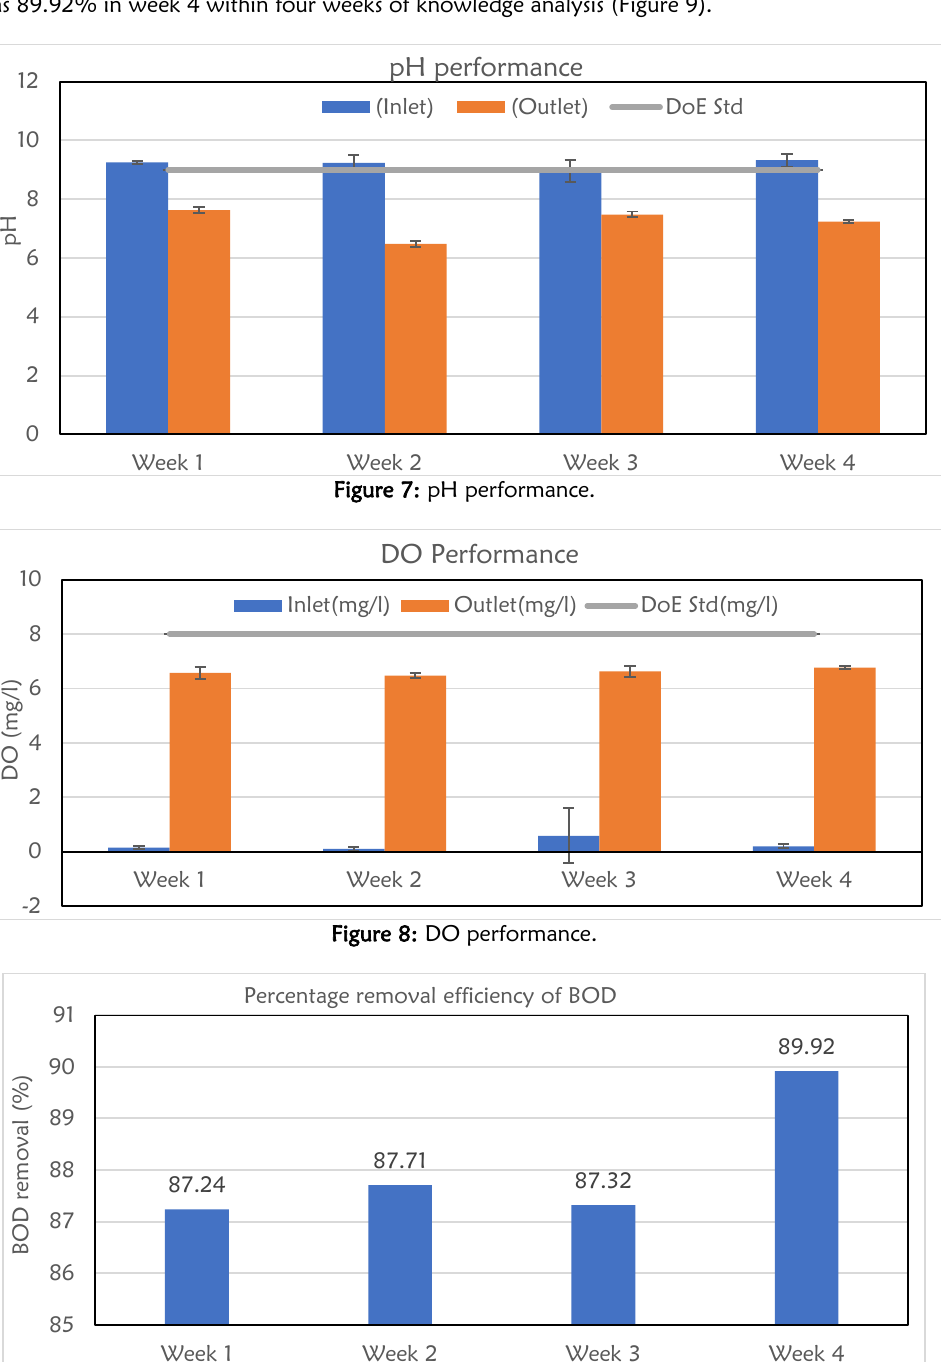
Figure 9: Percentage removal efficiency of TSS analysis of 4